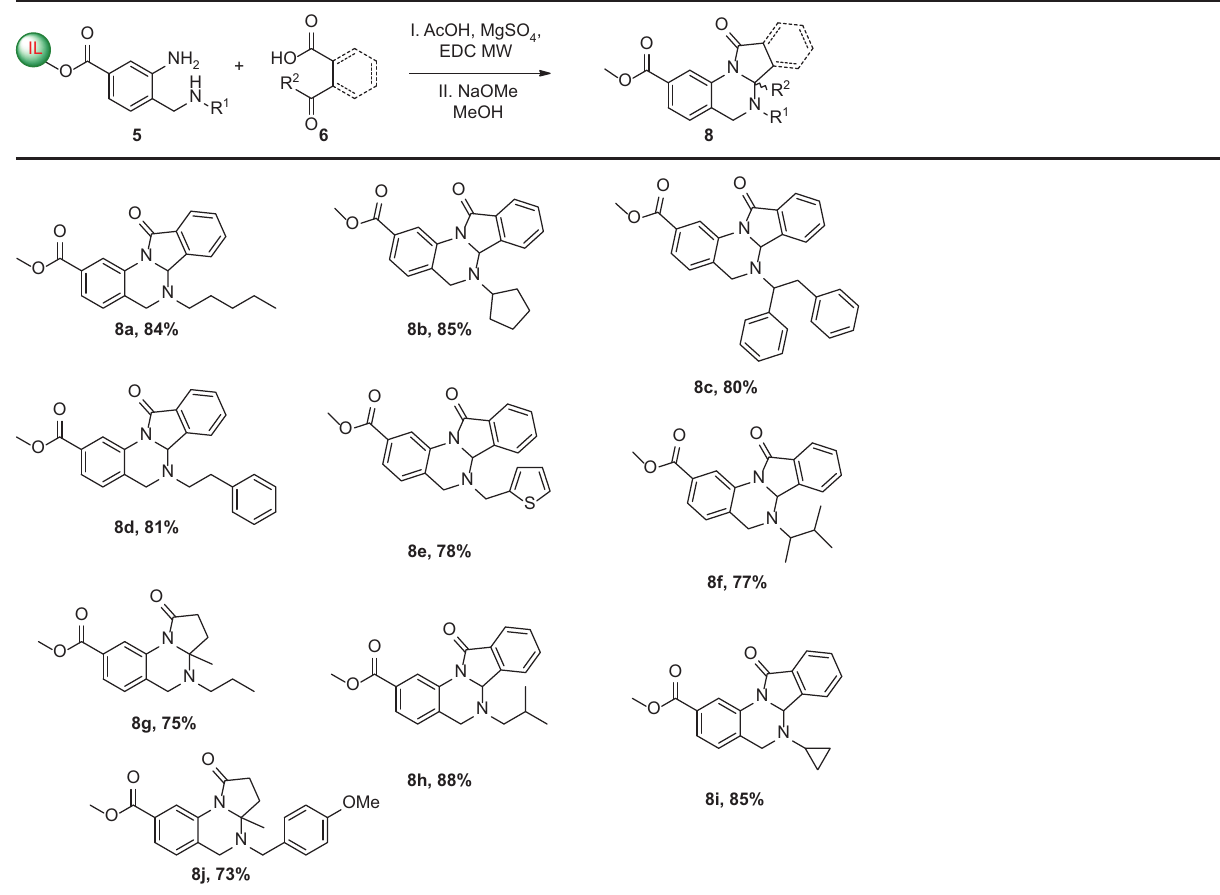
Table 1 Substrate scope of heterocyclization under microwave irradiation. a